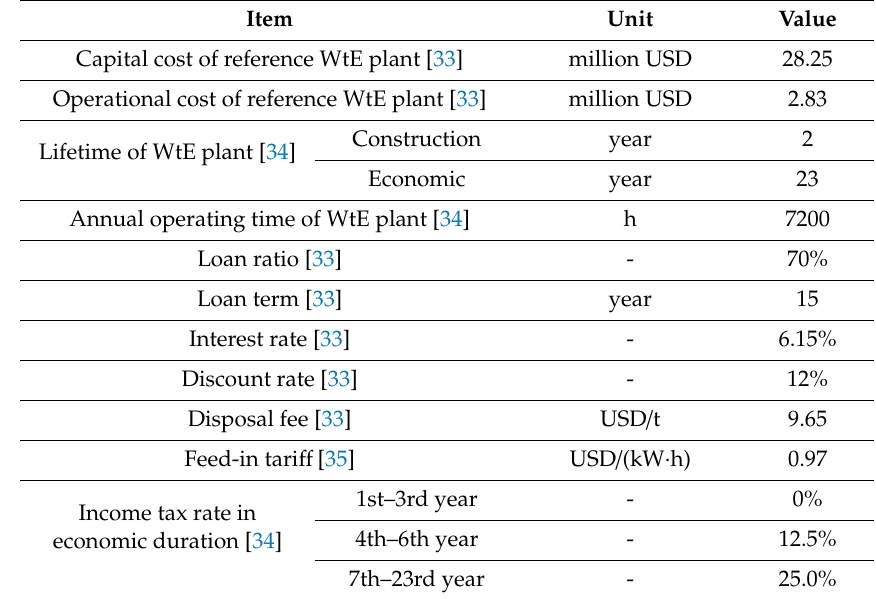
Table 11. Basic data for the economic analysis.